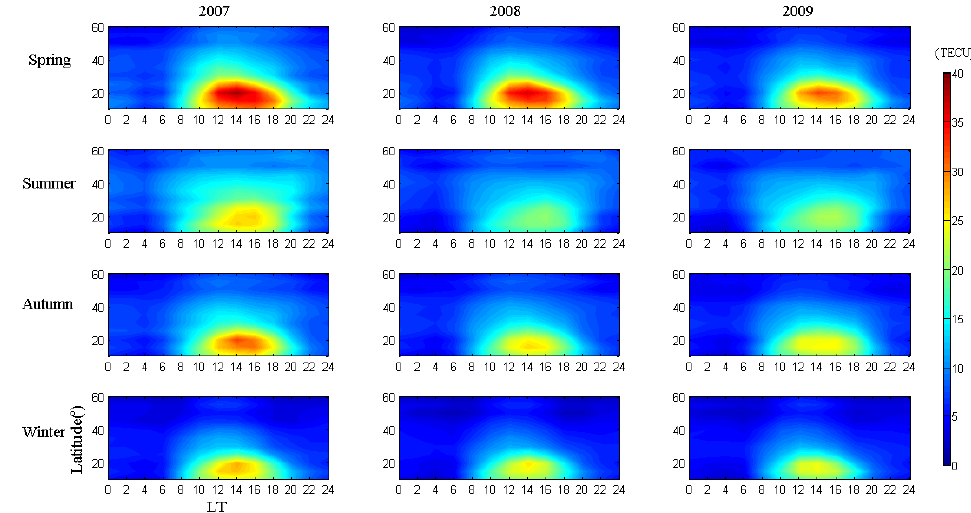
Figure 2. Latitudinal, diurnal and seasonal variation in TEC during the low-solar-activity period of 2007–2009.